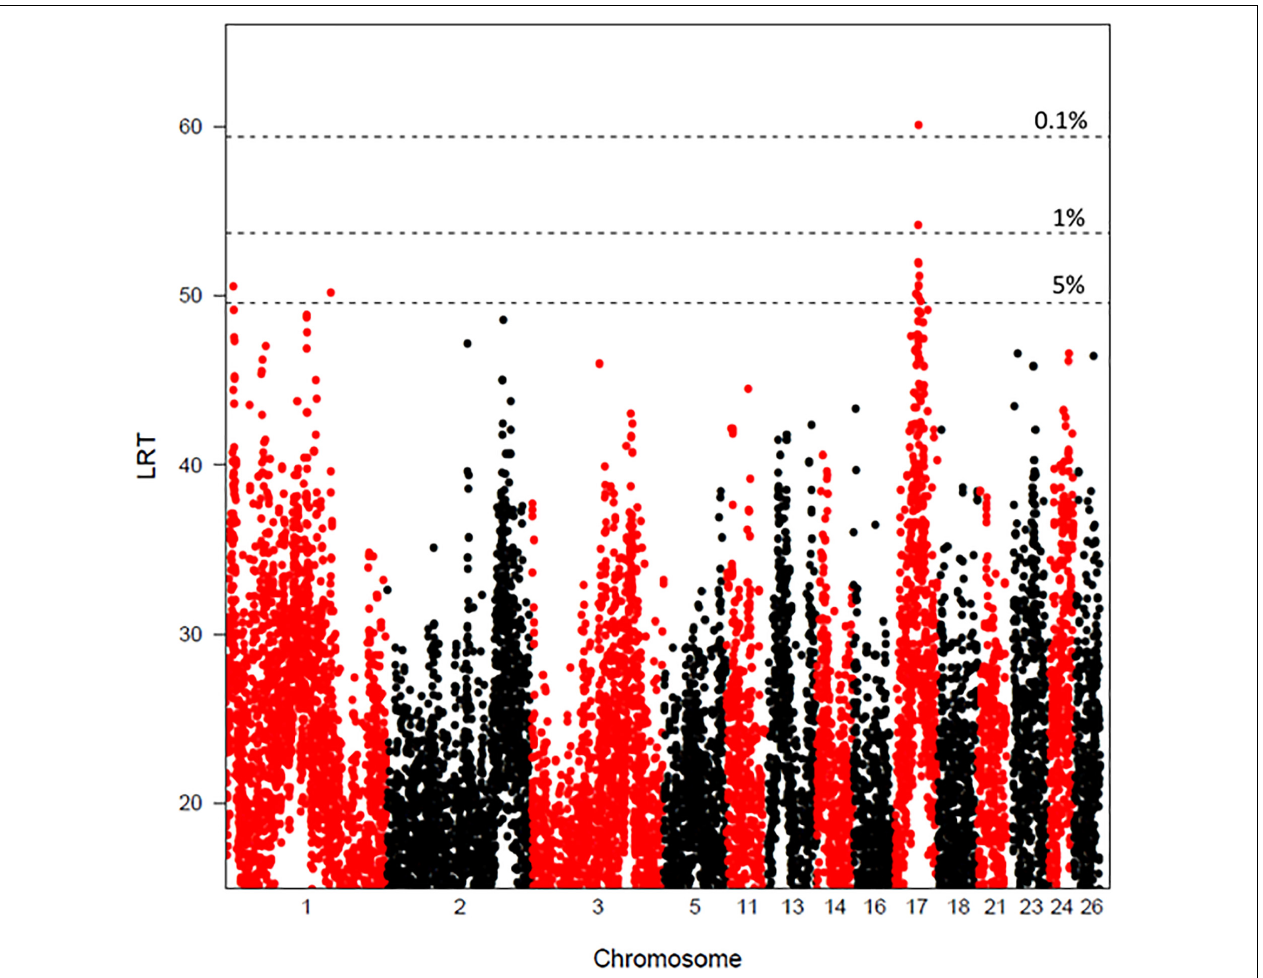
FIGURE 1 | Chromosome plots of the likelihood ratio test values obtained for global DNA methylation rate by LDLA analysis. The likelihood ratio test (LRT) is plotted against SNP haplotype positions (four consecutive SNPs) for chromosomes 1, 2, 3, 5, 11, 13, 14, 16, 17, 18, 21, 23, 24, and 26. The horizontal lines indicate the 5, 1, and 0.1% genome wide thresholds. One percent chromosome wide thresholds were OAR3, 47.6; OAR5, 37.4; OAR13, 42.6; OAR14, 35.9; OAR16, 38.7; OAR17, 42.3; OAR18, 40.6; OAR21, 37.3; OAR23, 45.7; OAR24, 42.8, and OAR26, 47.1. 5% chromosome wide thresholds were OAR1, 45.5; OAR2, 45.0; OAR11, 41.3; OAR13, 38.3; OAR24,